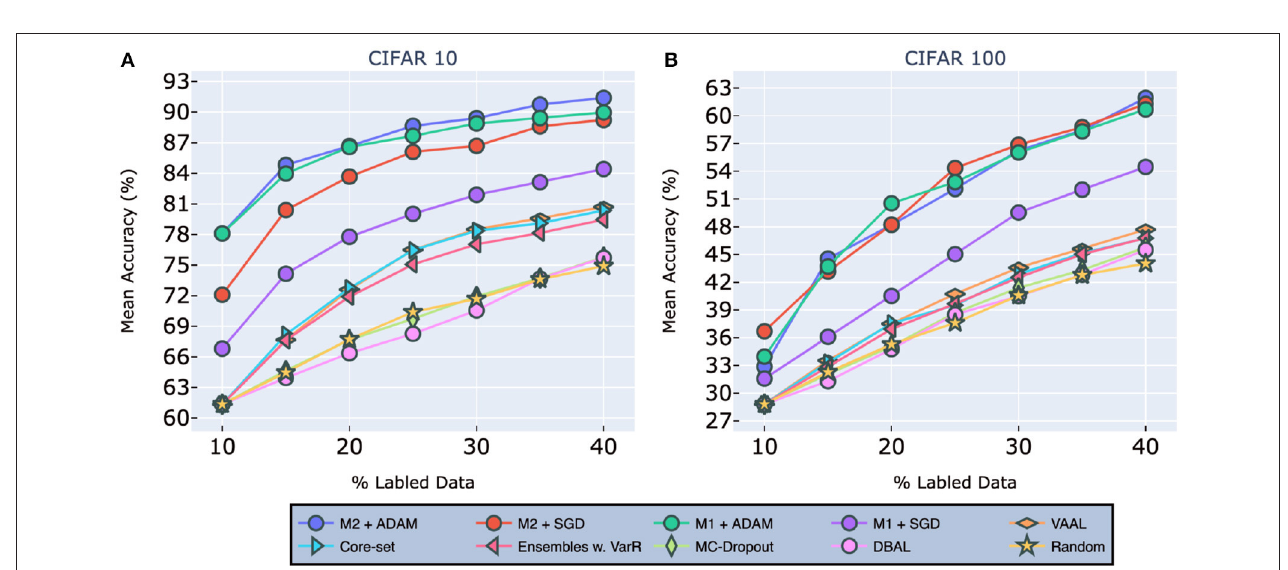
FIGURE 3 | ( A , left) Performance on FashionMNIST classification tasks using budget( b ) of 100 for model M 1 to WAAL (Shui et al., 2020), Core-set (Sener and Savarese, 2017), DBAL (Gal et al., 2017), BatchBALD (Kirsch et al., 2019), Random Sampling and Uncertainty Sampling. M1 indicates our model with Encoder and Classifier. ( B , left) Performance on CIFAR-10 classification tasks using budget( b ) of 1,000 for model M 1 . Best viewed in color.